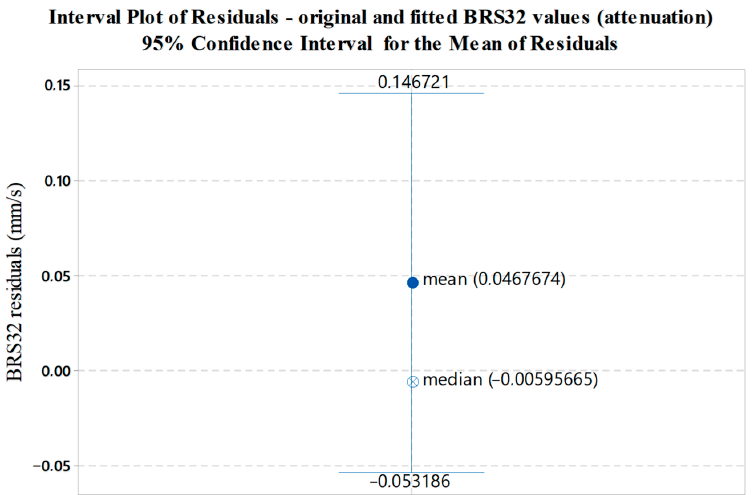
Figure 15. Graphical display of the variability of residuals (errors) between the measured and fitted BRS32 values with respect to data shown in Figure 12. Table 1. Summary of results obtained from in situ comparative measurements.